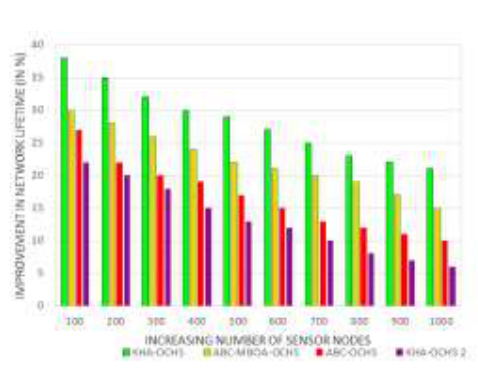
Figure 7 . Proposed NIUS-HEHOA-OCHS: Improvement in Network Lifetime under different network size